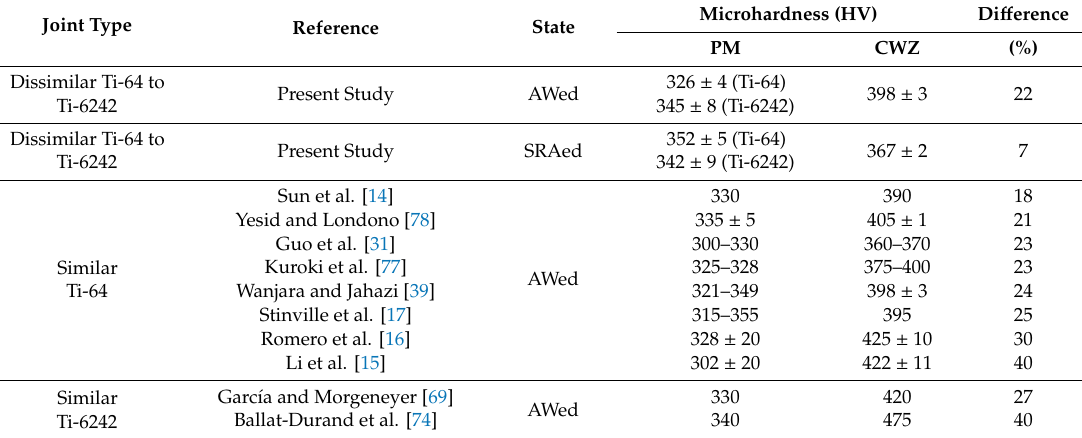
Table 4. Comparison of hardness in CWZ relative to